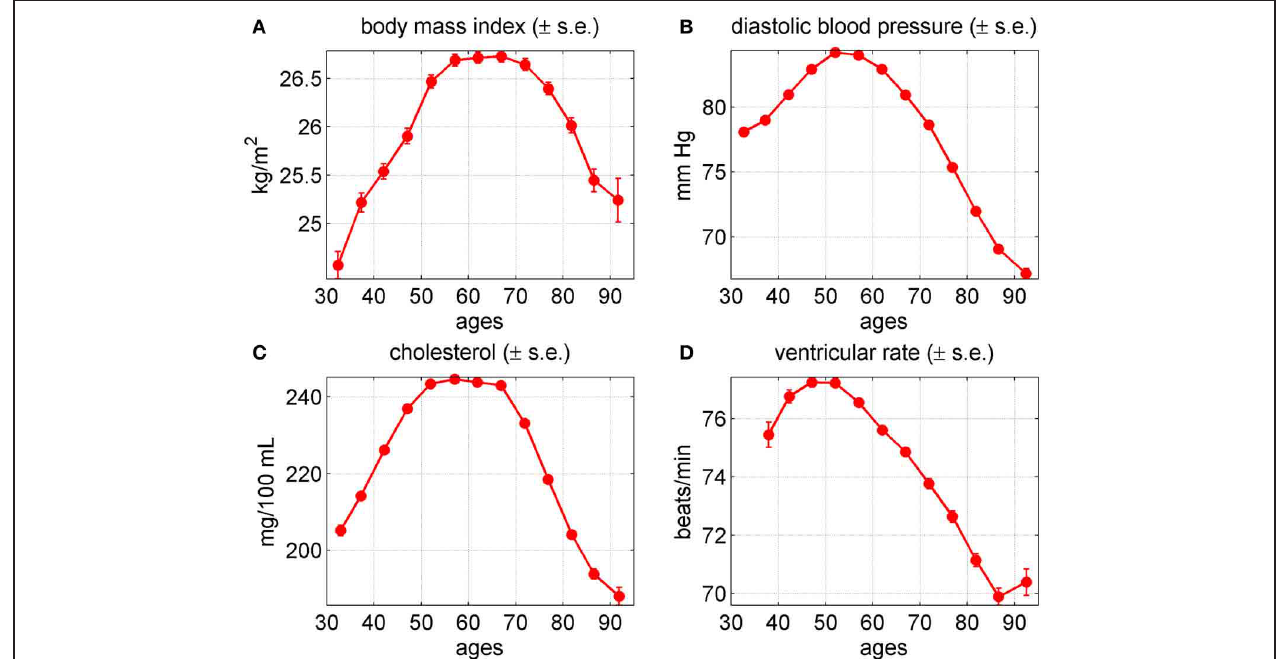
FIGURE 2 | Average trajectories ( ± standard errors) of four physiological variables in the Framingham Heart Study (original cohort, pooled data from exams 1–28). (A) Body mass index; (B) diastolic blood pressure; (C) cholesterol; (D) ventricular rate.